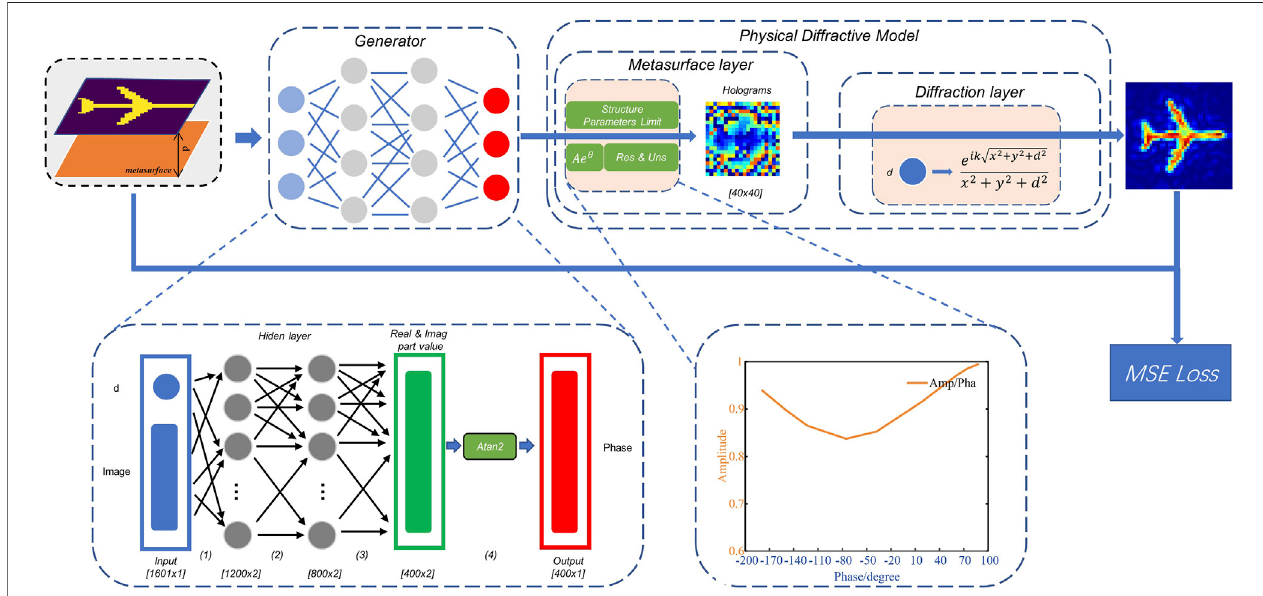
FIGURE 3 | Structure of GPDN, which comprises two modules: generator and physical diffractive model. Physical diffraction model includes metasurface and diffraction layers.